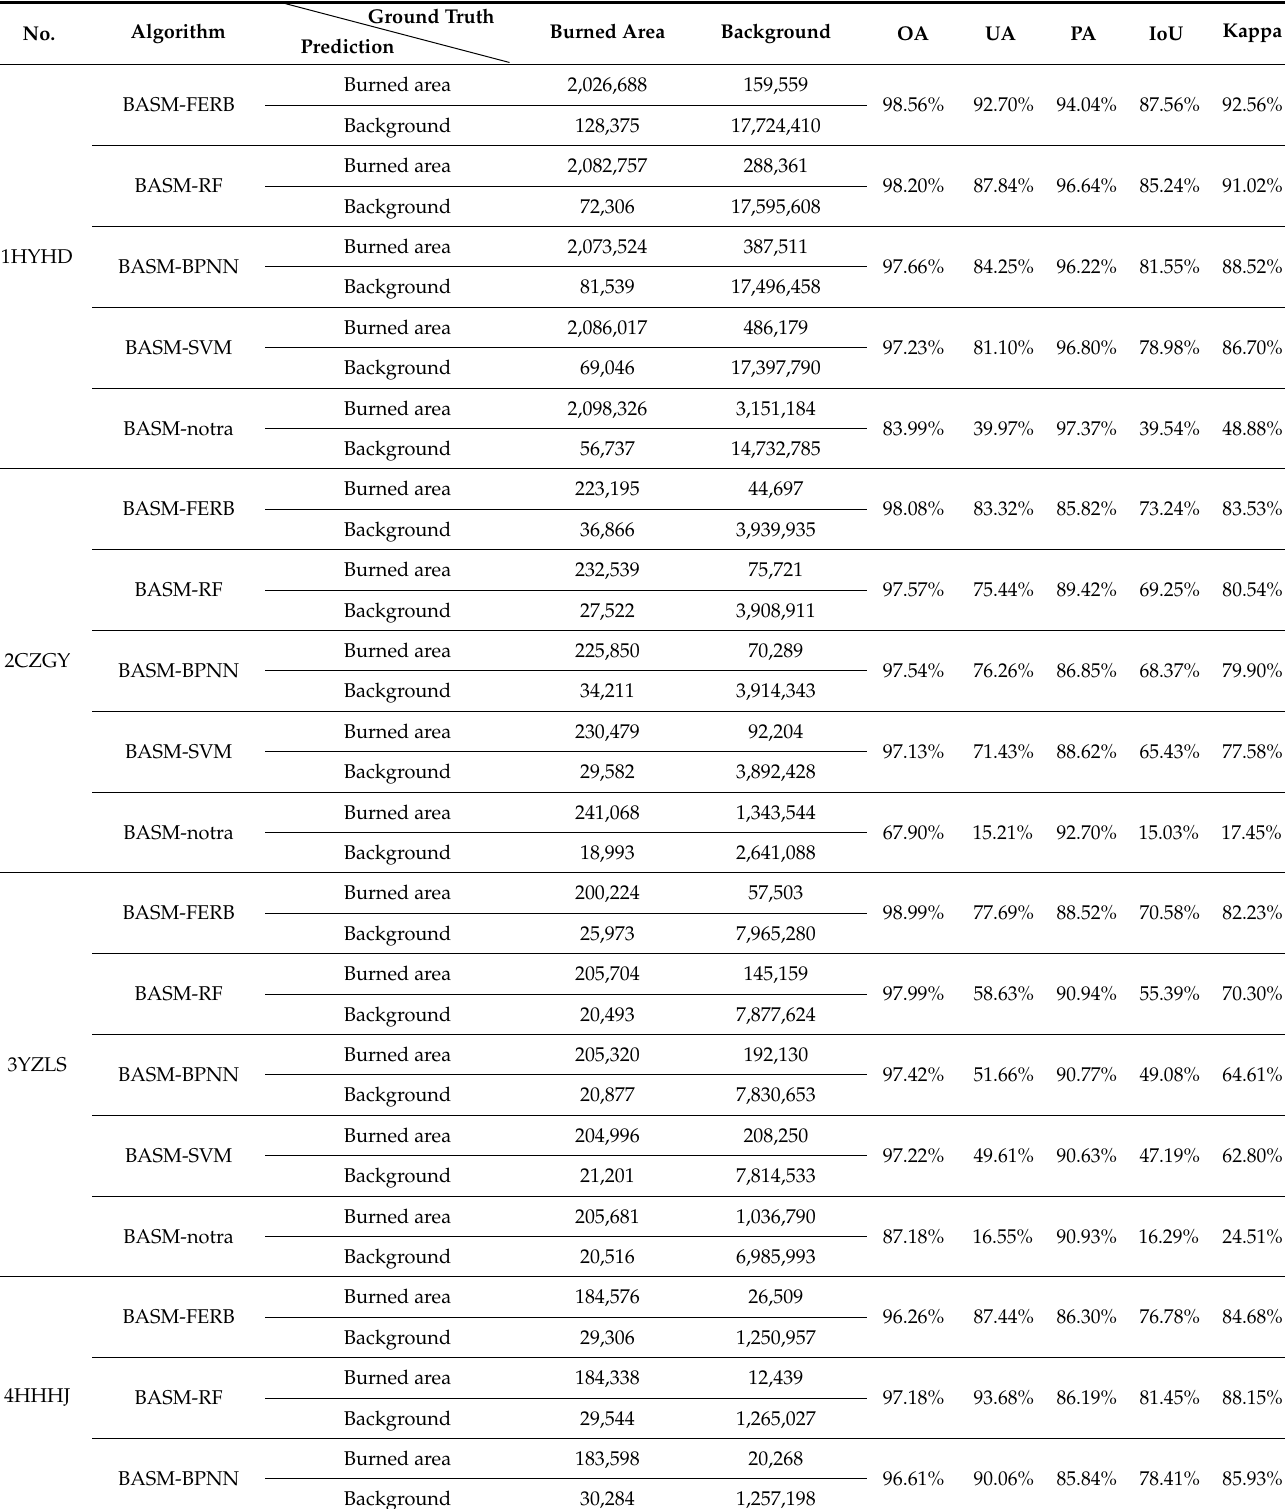
Table 6. A performance comparison among BASM-FERB, BASM-RF, BASM-BPNN, BASM-SVM, and BASM-notra using the Sentinel-2 images (scale =